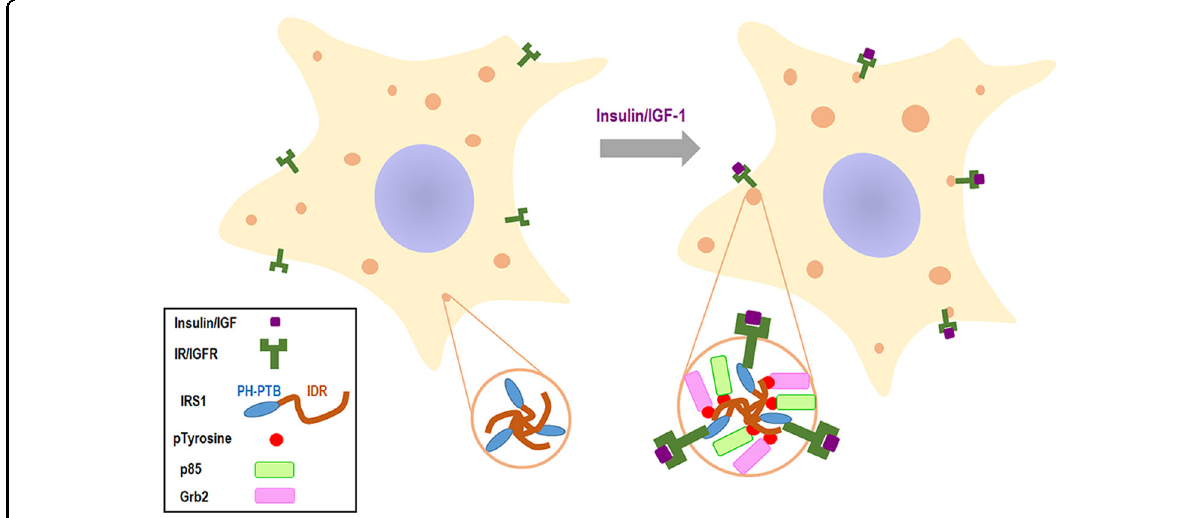
Fig. 7 Schematic model for IRS-1-mediated insulin/IGF signalosomes. We found that the C-terminus of IRS-1 undergoes phase separation through mediating self-association. Insulin/IGF signaling leads to tyrosine phosphorylation of IRS-1 which promotes the formation of IRS-1 droplets and the recruitment of downstream effectors to form insulin/IGF